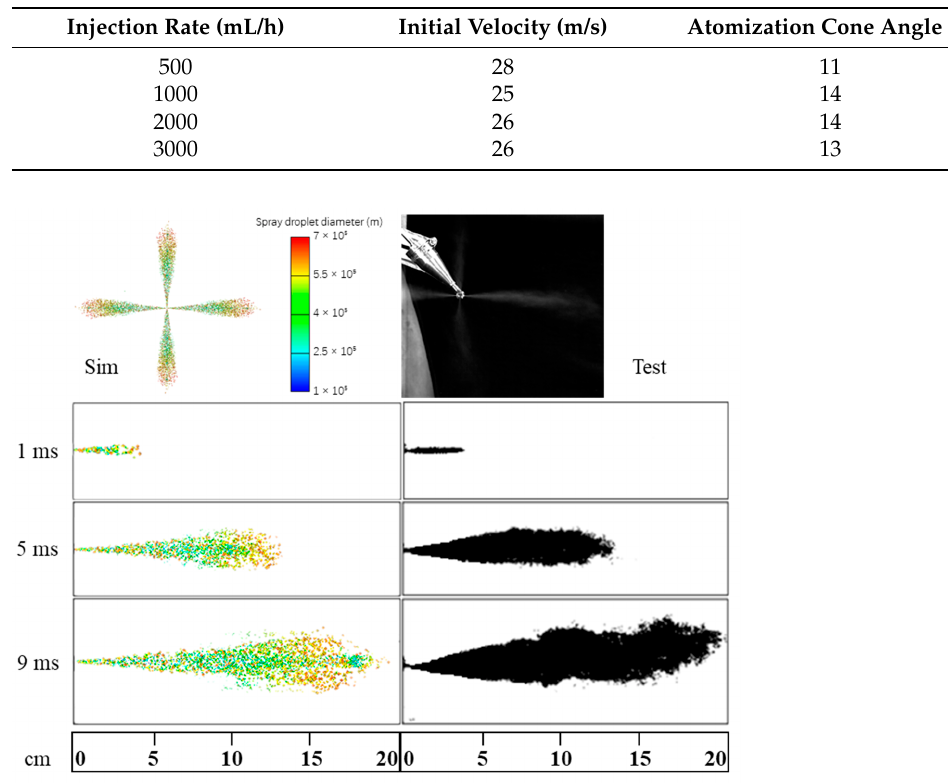
Figure 9. Comparison between simulation result and experimental result of spray morphology.